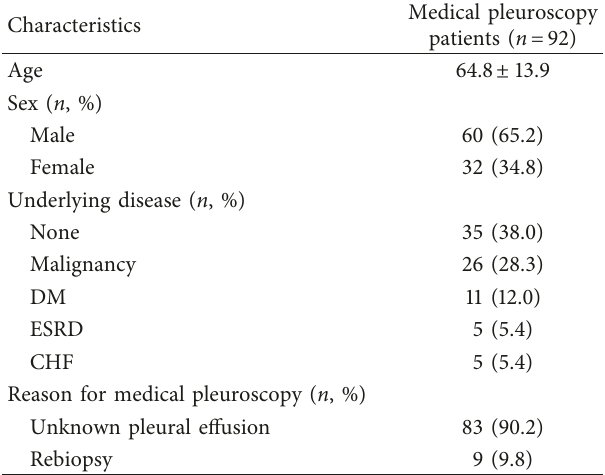
Table 1: Characteristics of the patients. Table 2: Characteristics of the pleural